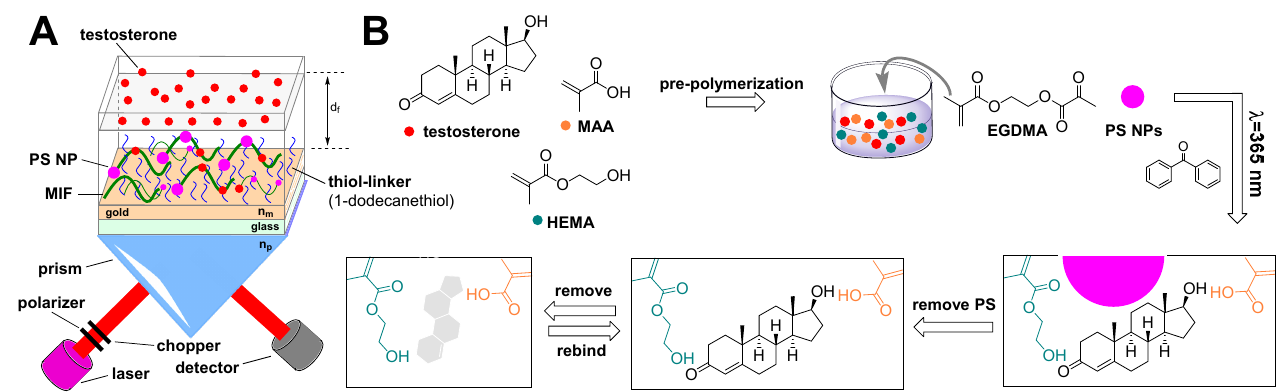
Figure 10. A diagram showing the setup of a surface plasmon resonance sensor ( A ), the PSNPs (polystyrene nanoparticles)–MIF (molecularly imprinted film)-functionalized sensor, and the schematic procedure of macroporous MIF formation ( B ). MIF was synthesized by photopolymerization of methacrylic acid (MAA), 2-hydroxyethyl methacrylate (HEMA), ethylene glycol dimethacrylate (EGDMA), and polystyrene nanoparticles (PSNPs) in combination with testosterone template molecules. This MIF-based sensor showed high stability and reproducibility for eight months when stored at room temperature [138].